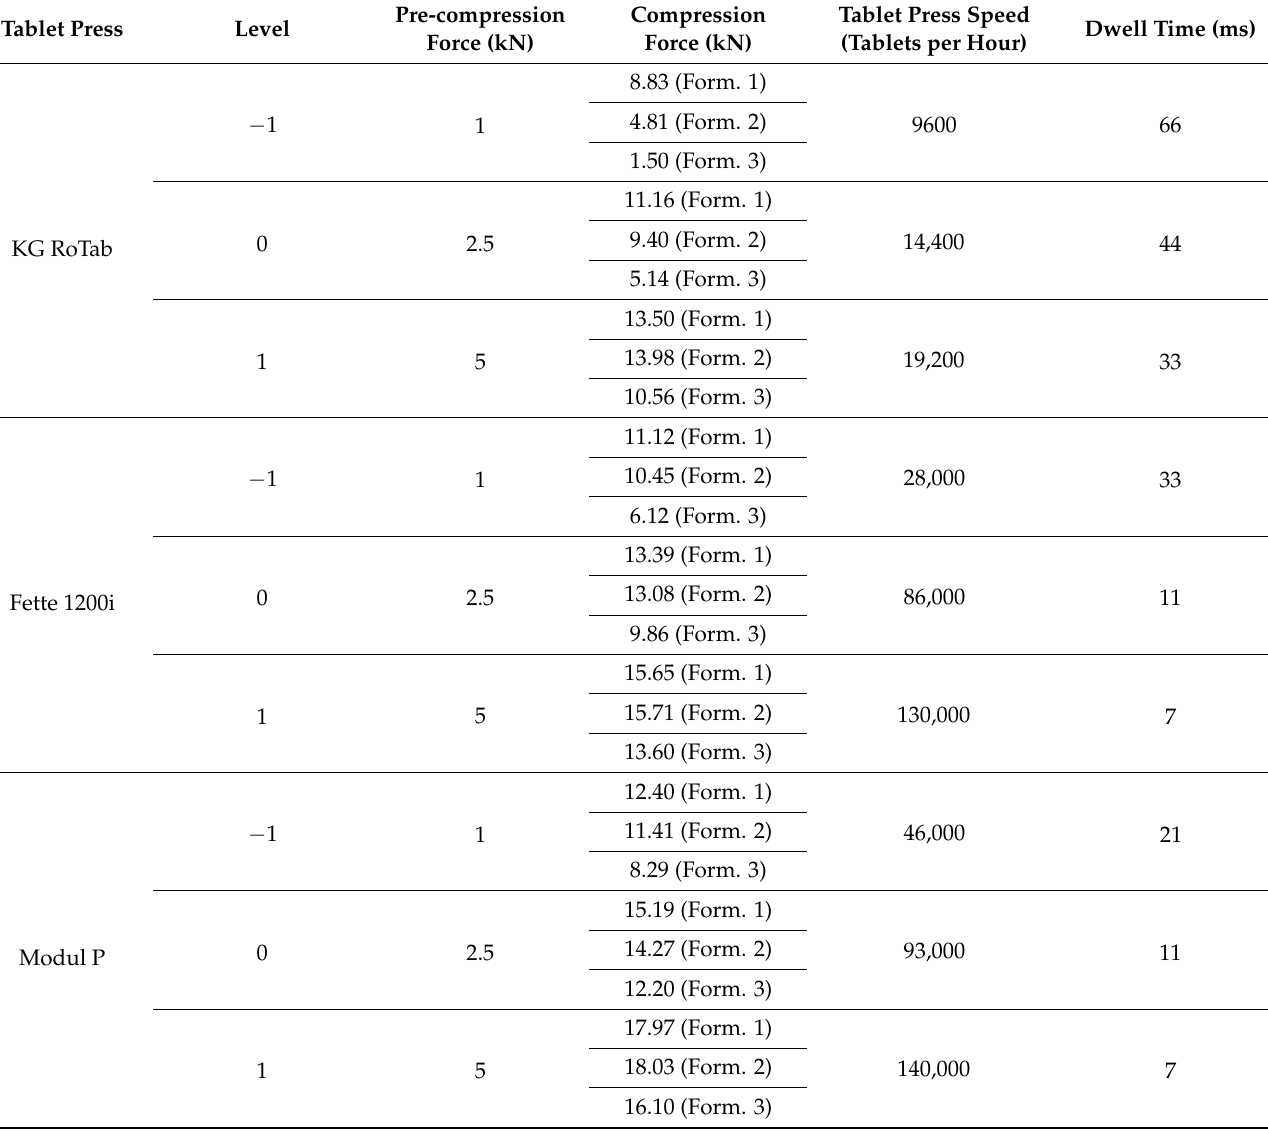
Table 2. DoE parameter levels investigated for each formulation on each tablet press: pre-compression force, main compression force, tablet press speed levels and associated dwell times for each tablet press. Form. 1, 2 and 3 refer to formulations 1, 2 and